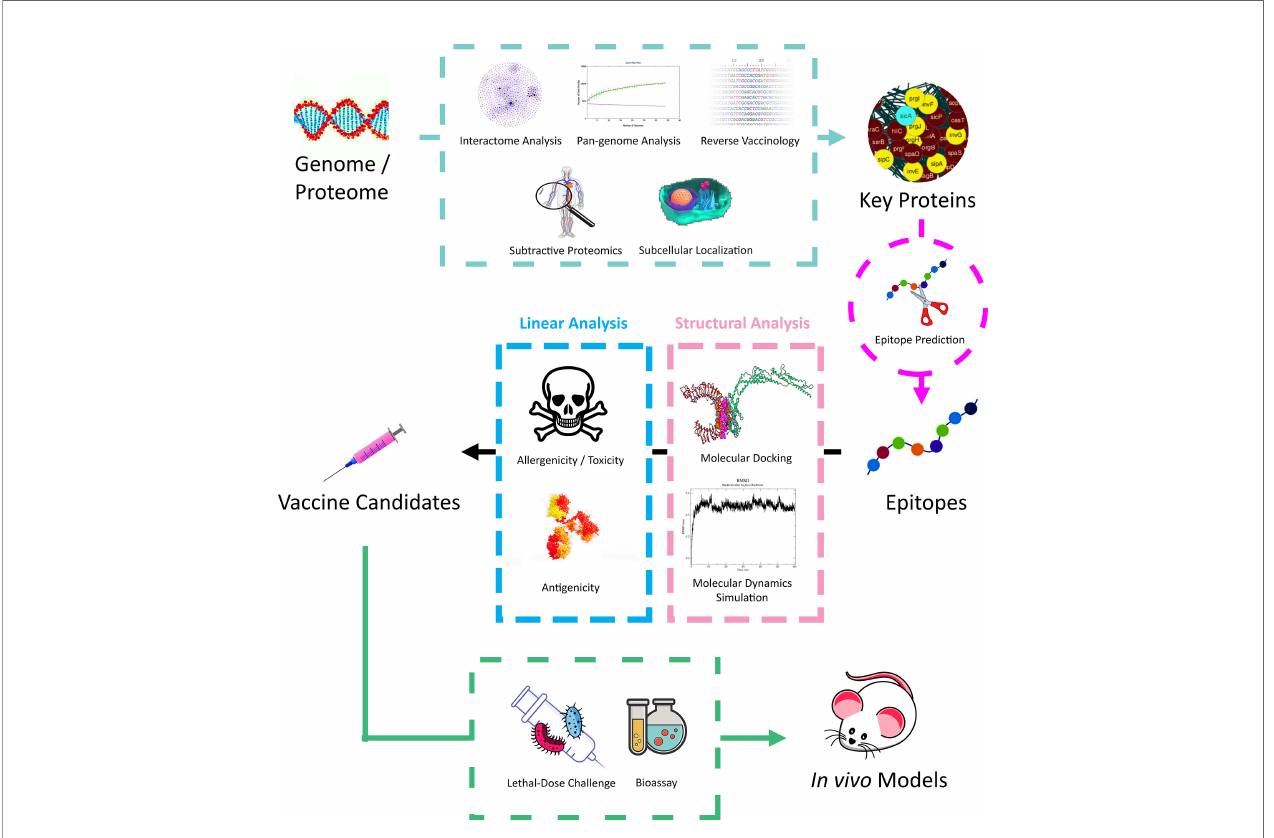
FIGURE 2 | A typical work fl ow of in silico vaccine design in recent studies on A. baumannii